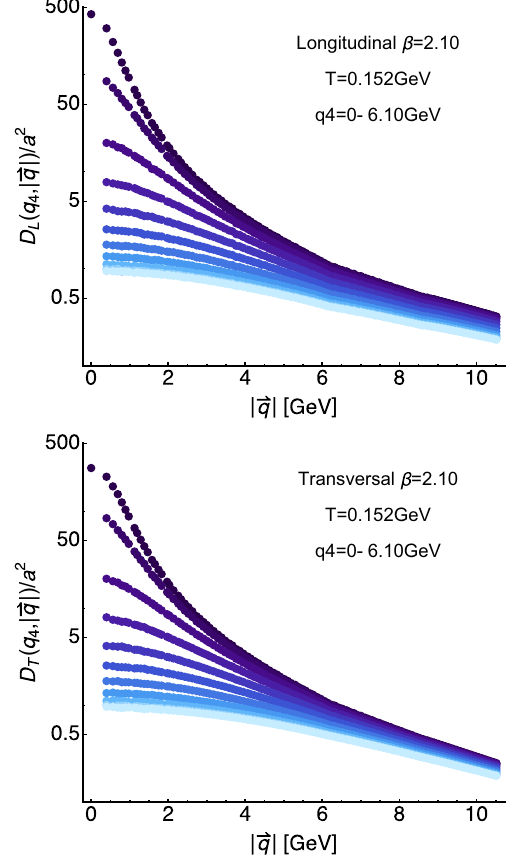
Fig. 4 The longitudinal (top row) and transversal (bottom row) gluon propagators at β = 2 . 10 evaluated at both finite imaginary frequency q 4 and spatial momentum | q | . We show the | q | dependence at fixed q 4